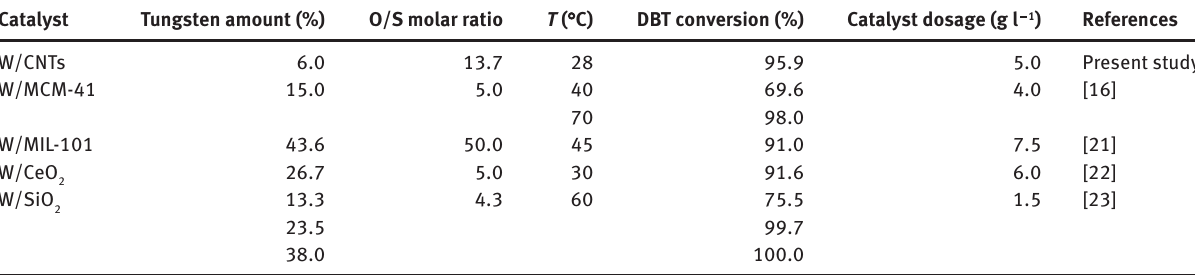
Table 1: Catalytic oxidation conditions of DBT in some studies.